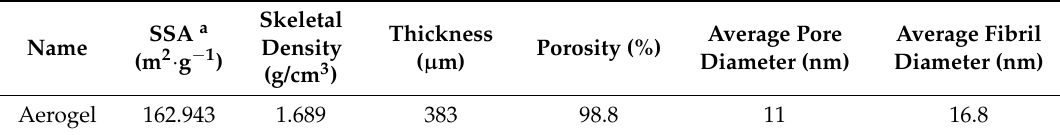
Table 3. Specific surface area (SSA), density, thickness, porosity, average pore and fibril diameter values obtained for the